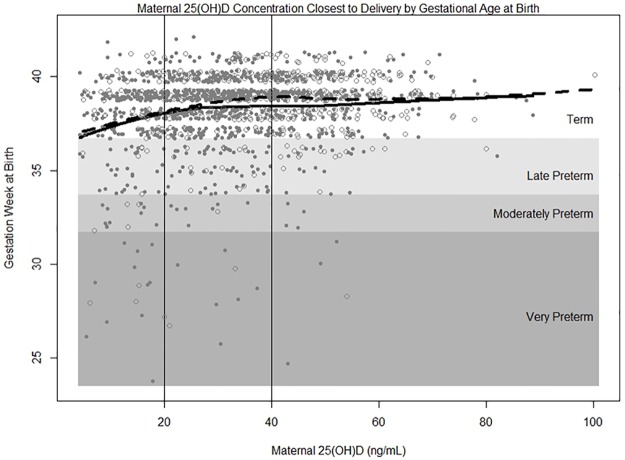
Maternal 25(OH)D concentration by gestational age (weeks) at birth.Term birth is ≥37 weeks of gestation, late preterm birth is 34 to <37 weeks, moderately preterm is 32 to <34 weeks, and very preterm is <32 weeks. Solid gray circles and solid black line represent MUSC cohort (N = 1064) and open circles and dashed line represent Hollis and Wagner et al. trial cohort (N = 509).